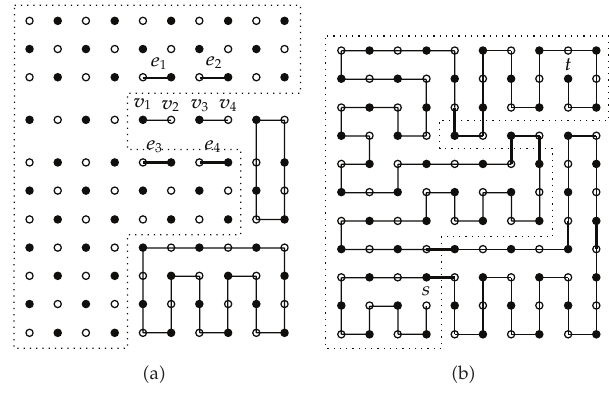
Figure 6: A Hamiltonian path in R (cid:6) 7 , 11 (cid:7)